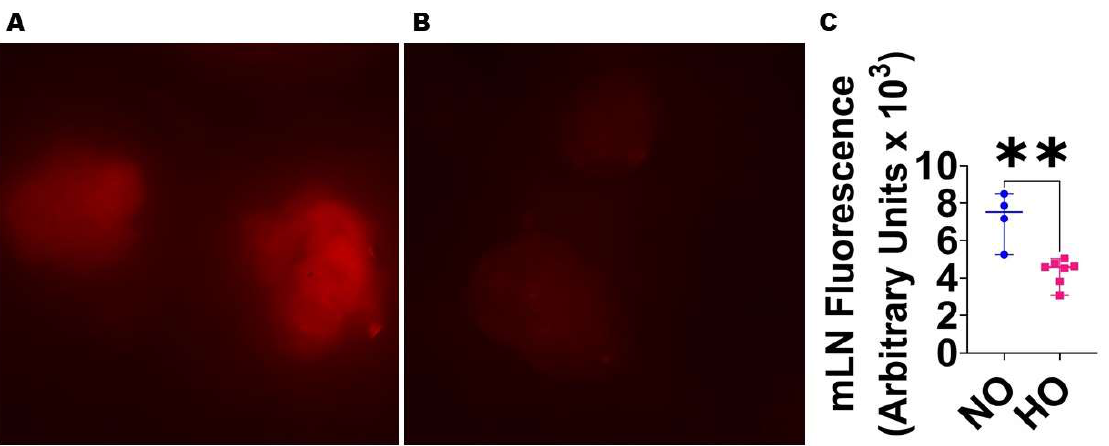
Figure 7. Lung PDPN + lymphatic density in neonatal mice exposed to HO. The lung lymphatic density was determined by quantifying PDPN + lung vessels (arrows) on P7 in WT mice exposed to 21% O 2 (NO) or 70% O 2 (HO) from P1 to P7. ( A – B ). Representative PDPN + (green) and DAPI (blue) immunofluorescence-stained lung vessels from mice exposed to NO ( A ) and HO ( B ) for 7 d. ( C ). Representative lung section from NO exposed animals stained with secondary antibody only (negative control). Scale bar = 100 µ m. ( D ). Quantification of PDPN + lung vessels. Values are presented as the median with the range ( n = 3/group). Significant differences between exposures are indicated by * p < 0.05 ( t -test).